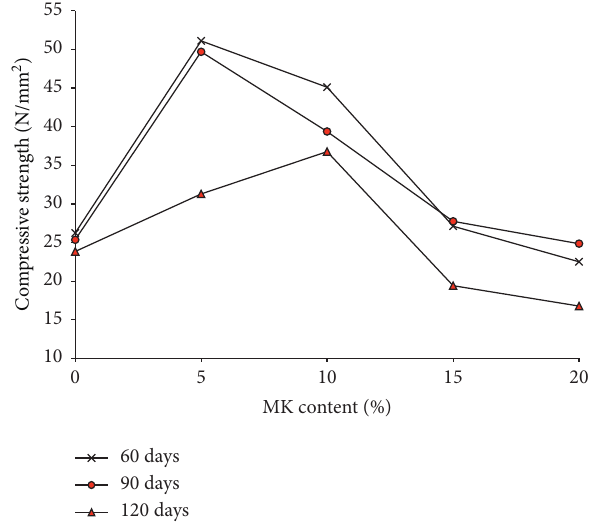
Figure 10: Compressive strength for chloride attack